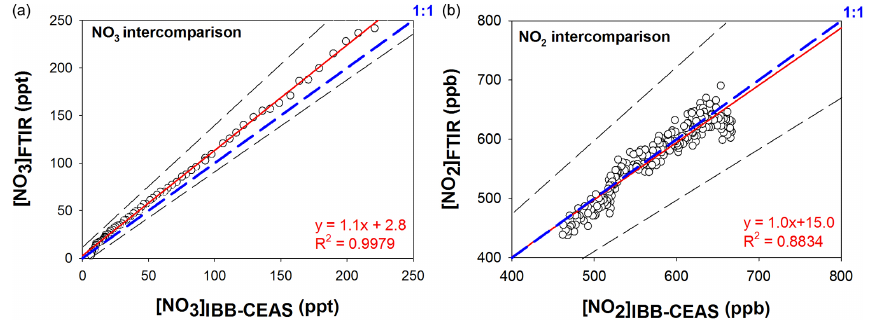
Figure 6. Correlation between FTIR and IBBCEAS measurements for NO 3 (a) and NO 2 (b) . Uncertainties are shown by dashed straight lines. Dashed blue lines show the 1:1 ratio.